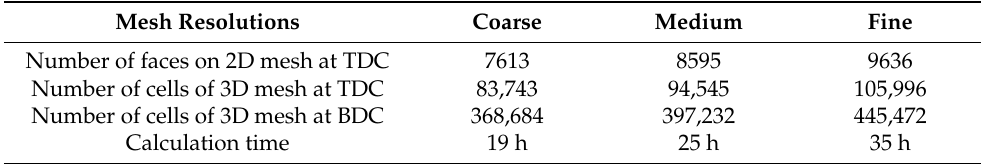
Table 4. Mesh metrics and corresponding calculation time.